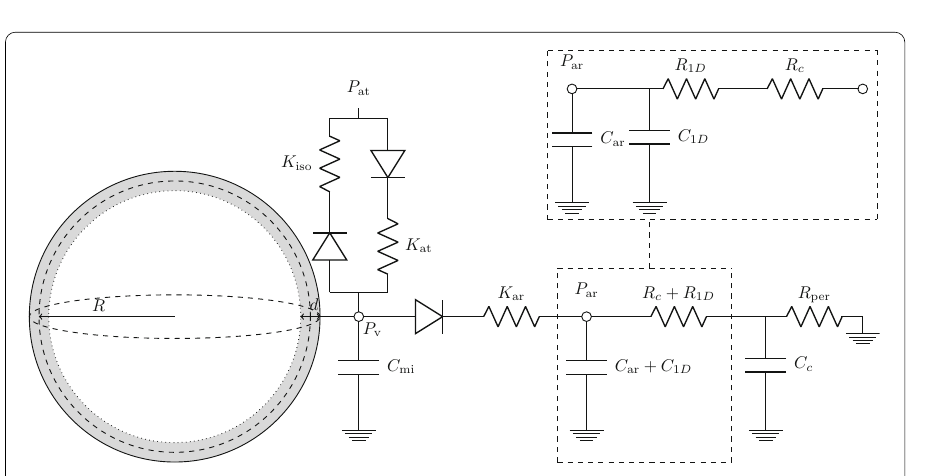
Fig. 5 Scheme of the uncoupledcardiacmodel : reduced cardiac model with a lumped-parameter model as boundary conditions to represent the entire circulation. The configuration is obtained from the fullycoupled model by reducing the 1D vessel to an